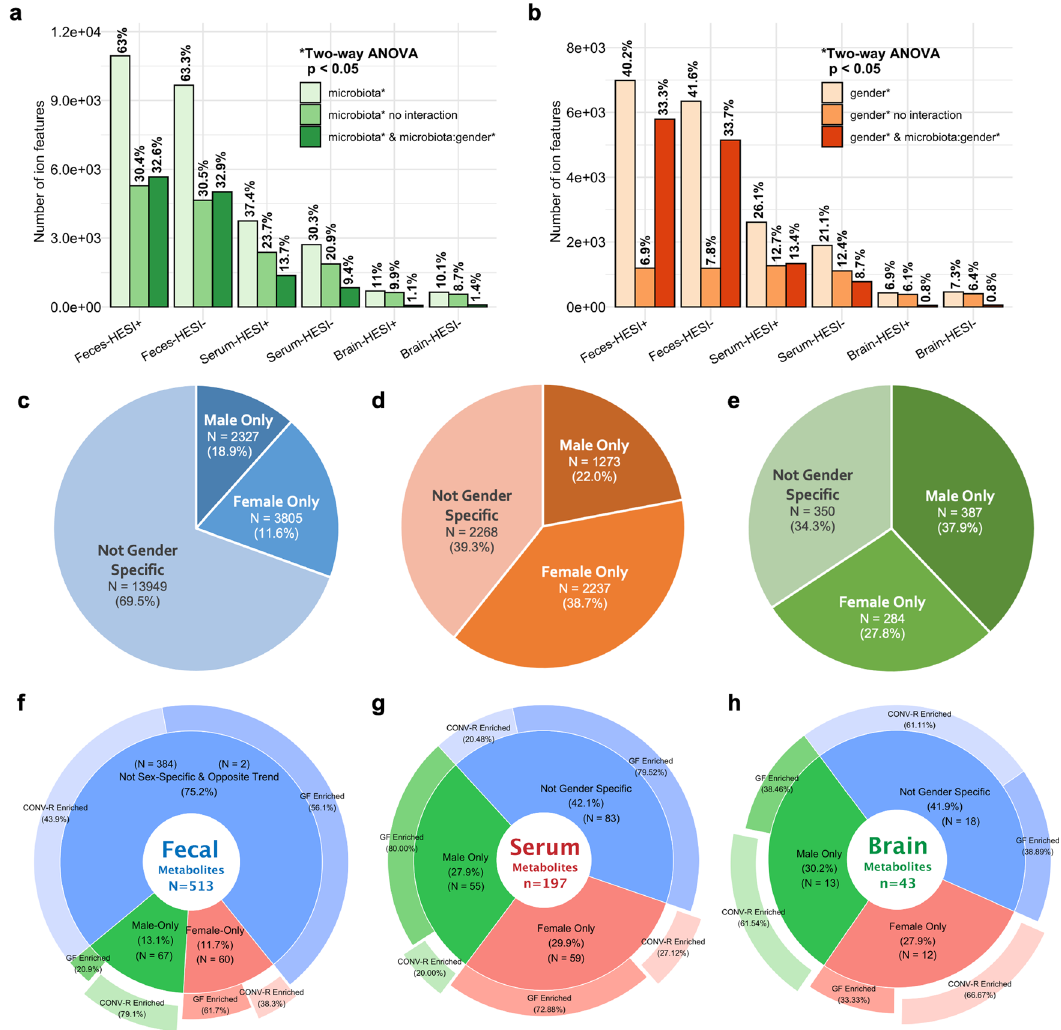
Fig. 8 Microbial rewiring of host metabolism and gut-brain axis exhibits gender-speci fi c characteristics. a Proportions of ion features with signi fi cant main effects of microbiota as determined by two-way analysis of variance (ANOVA) (adjusted p < 0.05). b Proportions of ion features with signi fi cant main effects of gender as determined by two-way ANOVA (adjusted p < 0.05). c – e Pie charts for gender-speci fi c distribution of ion features in feces ( c ), sera ( d ), and cerebral cortical brain ( e ) combining both HESI positive and negative modes that had main effects of microbiota (two-way ANOVA, adjusted p < 0.05) while exhibiting statistical GF/CONV-R difference in at least one gender (post hoc Tukey ’ s HSD test, adjusted p < 0.05). f – h PieDonut charts for gender-speci fi c distribution of the identi fi ed compounds in feces ( f ), sera ( g ), and cerebral cortical brain (h) as determined by two-way ANOVA (adjusted p < 0.05) and post hoc Tukey ’ s HSD test (adjusted p <